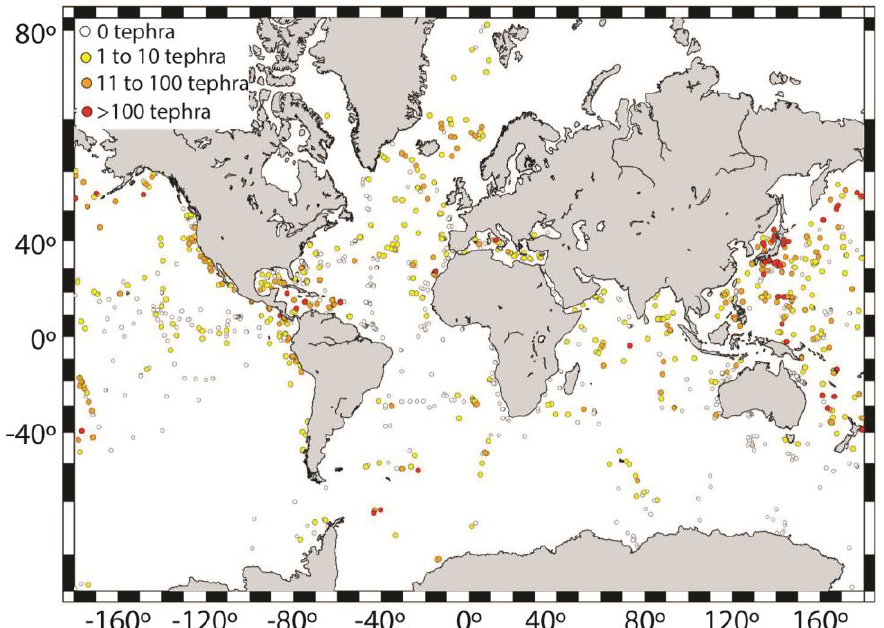
Figure 2. (Reproduced from reference [6]). Distribution of ocean sediment cores from DSDP, ODP, and IODP cruises as reflected in the VOLCORE database, coloured to indicate the number of tephra layers found at each site. Coastal areas where cores record many ash deposits (e.g., Japan, the Caribbean) reflect highly active volcanic systems in these areas. More remote cores with many tephra layers may indicate locations close to volcanic islands or simply very long cores. The VOLCORE database can be found at https://doi.org/10.1594/PANGAEA.934363 (accessed on 18 March 2023).